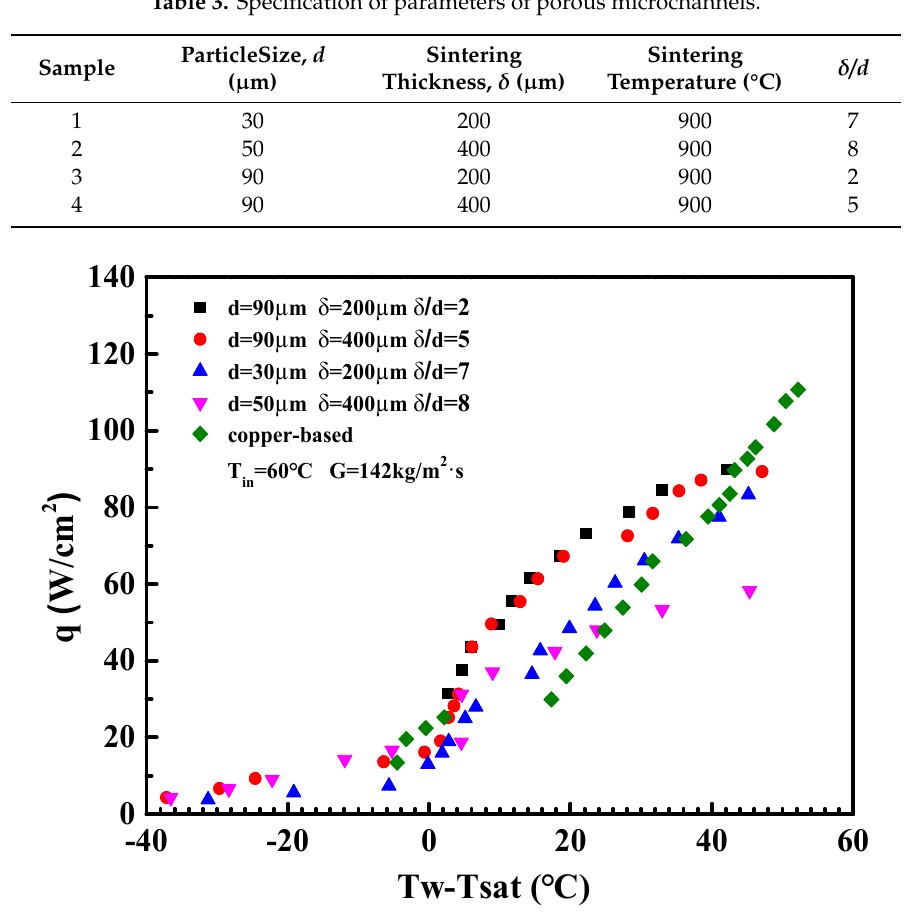
Figure 8. The boiling curves of porous microchannels and the copper-based microchannel.